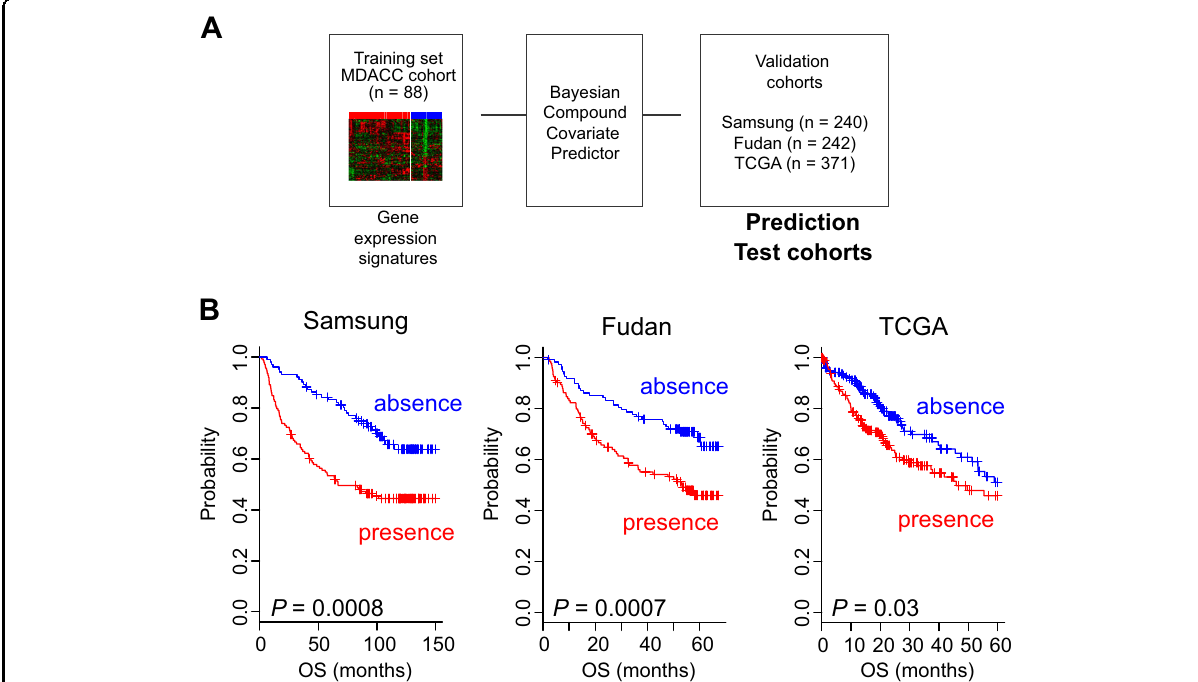
Fig. 3 Validation of the association between the APOB-silenced signature and prognosis in hepatocellular carcinoma. a Schematic diagram of the prediction model. b Kaplan – Meier plots of patient overall survival (OS) in the validation cohorts (Samsung, Fudan, and TCGA)